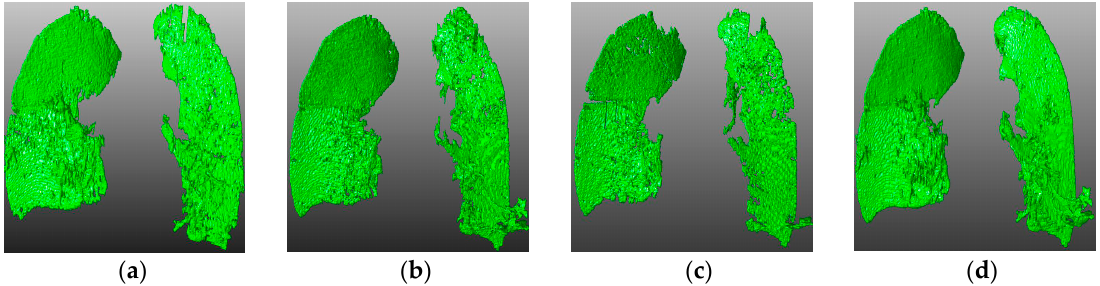
Figure 7. Fissure segmentations, respectively, corresponding to ( a ) F A , ( b ) F S , ( c ) F C and their integration ( d ).